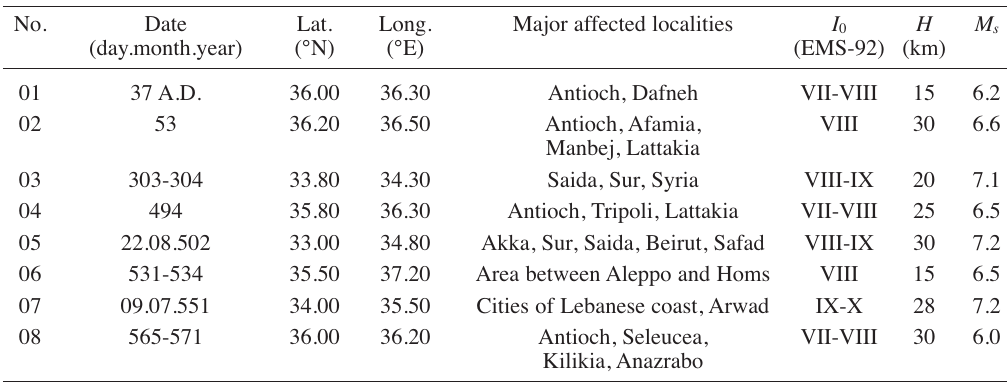
Table I. Parametric catalogue of large historical earthquakes in Syria and its surroundings. The magnitude is calculated following Shebalin (1970), Ambraseys and Barazangi (1989) and Ambraseys (1997).